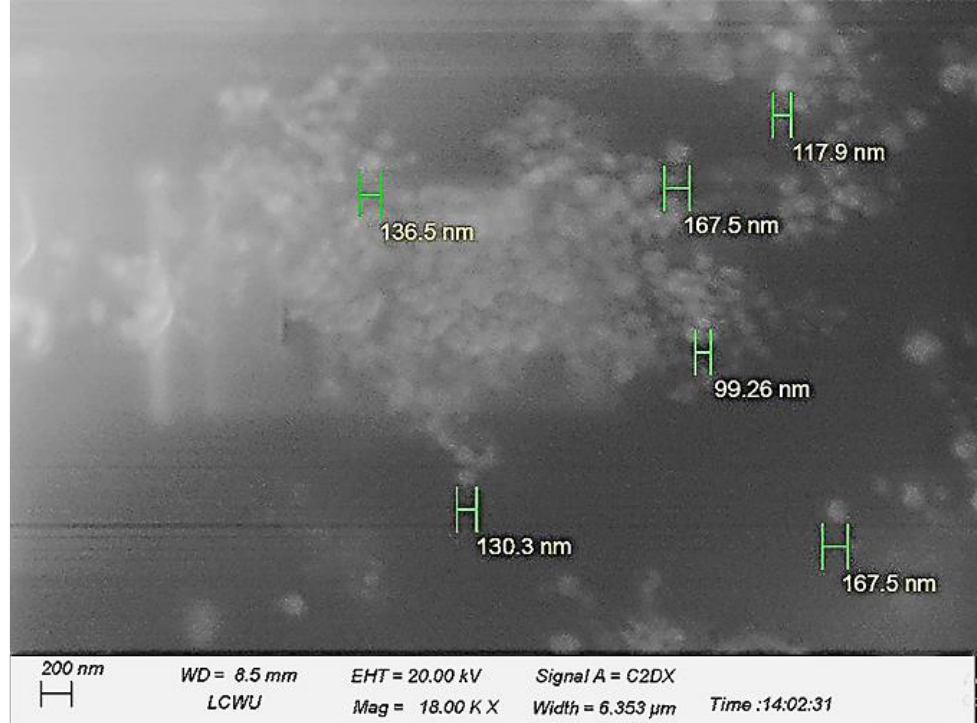
Figure 1. Scanning electron microscopy (F1 formulation), indicating the nano-sized globules with an appropriate spherical shape, well apart from each other.